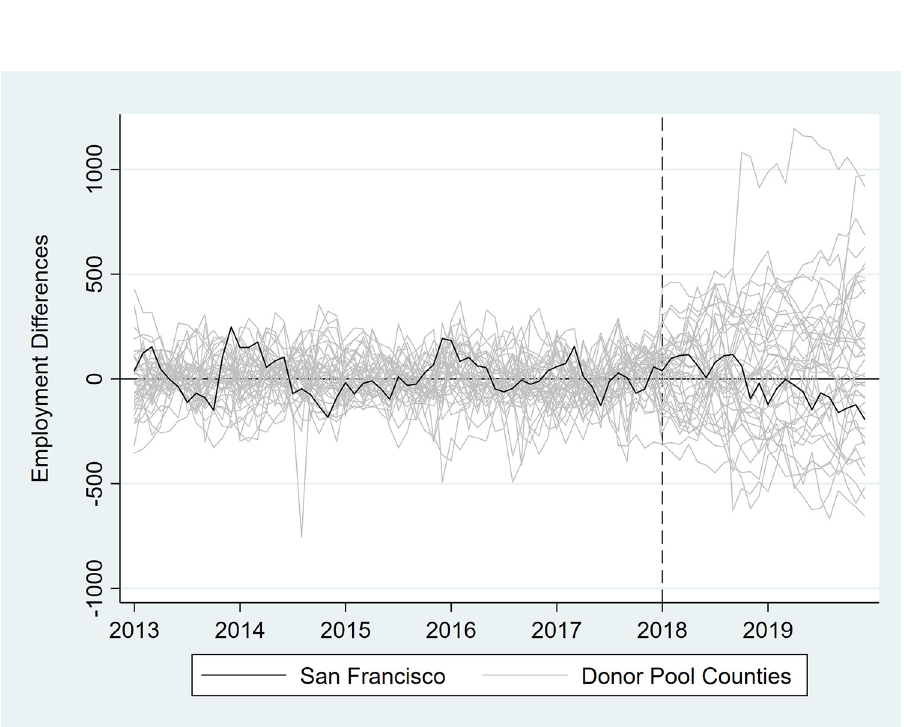
Fig 9. Differences in employment outcomes between each county and its synthetic control for supermarket and other grocery store employment.